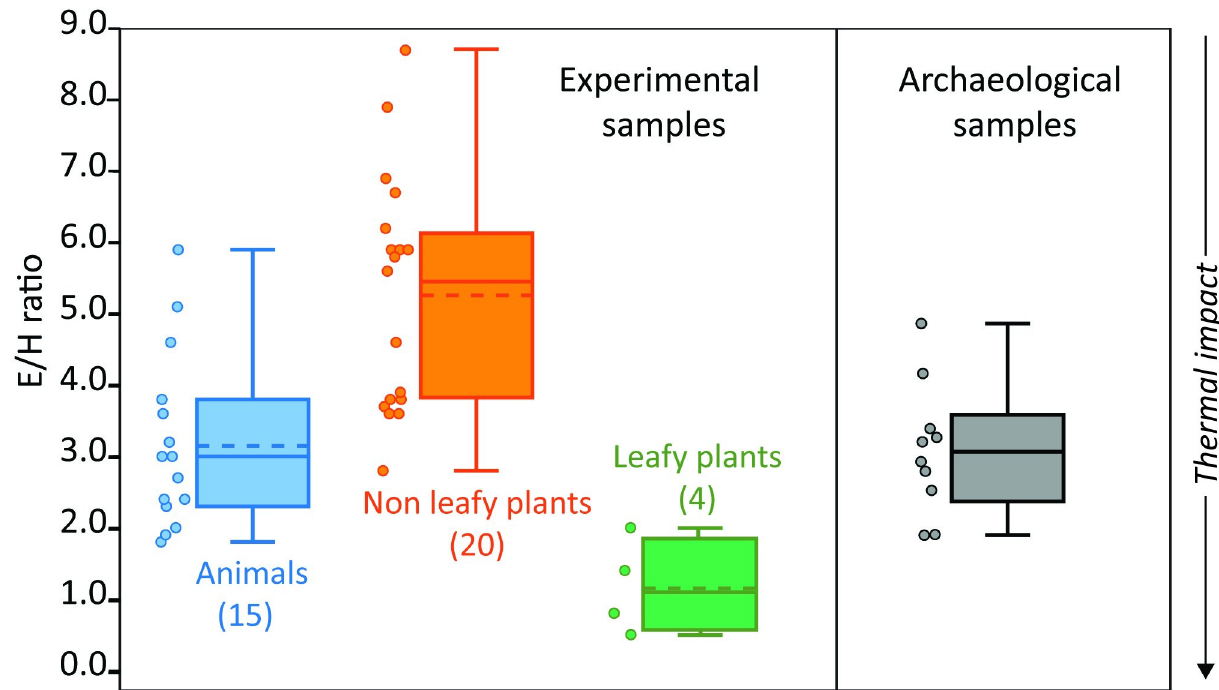
Fig 11. Boxplots of E/H ratio of modern references thermally degraded in the laboratory [57] and Siwa archaeological samples. Plots represent median (solid line), mean (dashed line), ranges and quartiles. The arrow (thermal impact) shows the effect of increasing temperature on the E/H